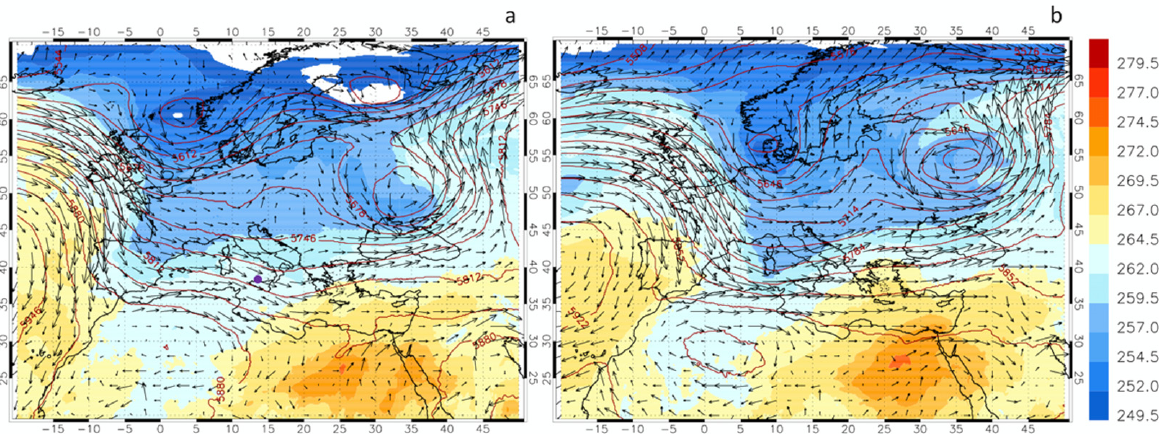
Figure 2. Geopotential height (blue contours), temperature (filled contours), and wind vectors at 500 hPa at 12:00 UTC on